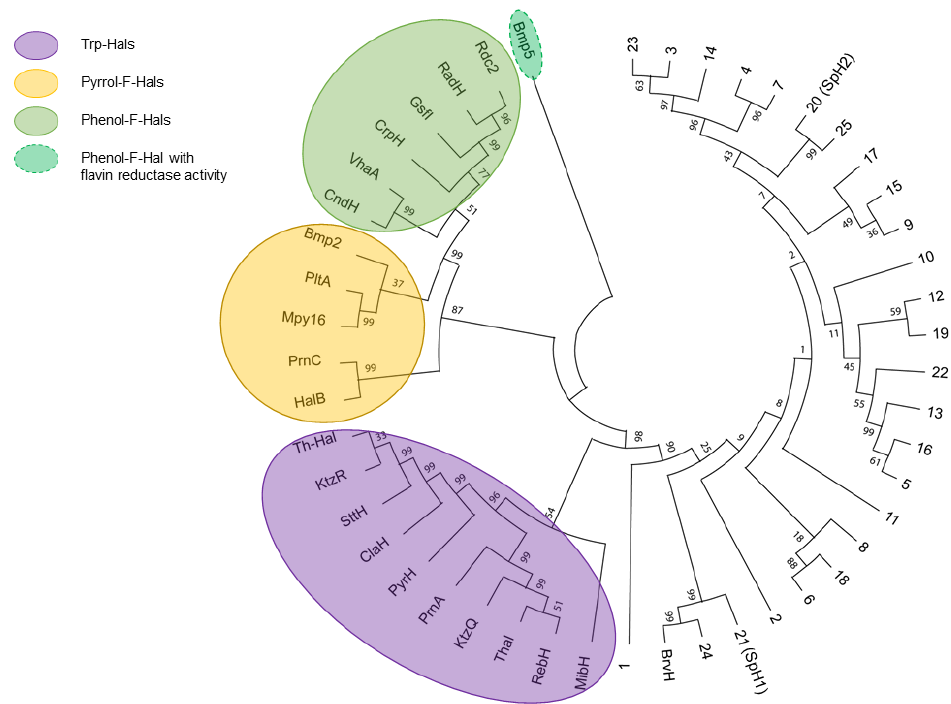
Figure 1. Phylogenetic tree of the hits from the Botryococcus braunii consortia, as well as known Trp halogenases, phenol halogenases, and pyrrol halogenases. The optimal tree, with the sum of branch lengths = 17.80254621, is shown. The newly identified hits all cluster with the flavin-dependent halogenase BrvH. We decided to further analyse hit 21 (SpH1) and hit 20 (SpH2).